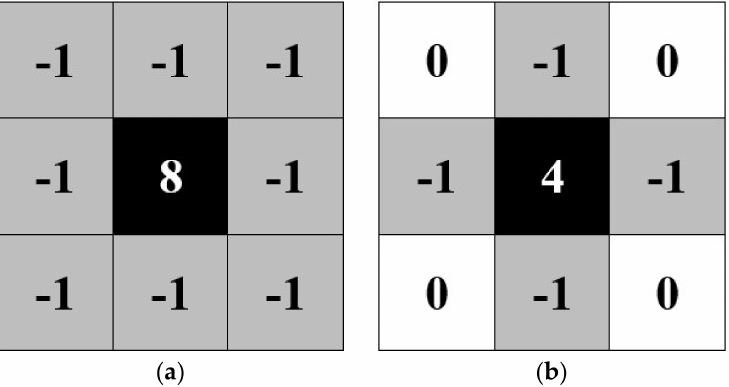
Figure 5. ( a ) 8-pixel connectivity; ( b ) 4-pixel